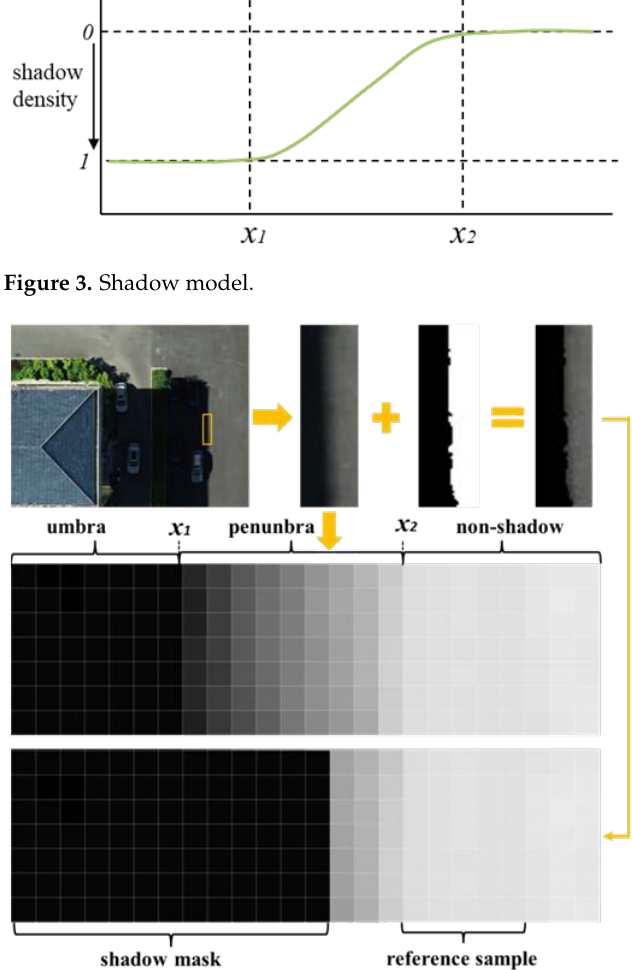
Figure 4. Penumbra schematic. Figure 4. Penumbra